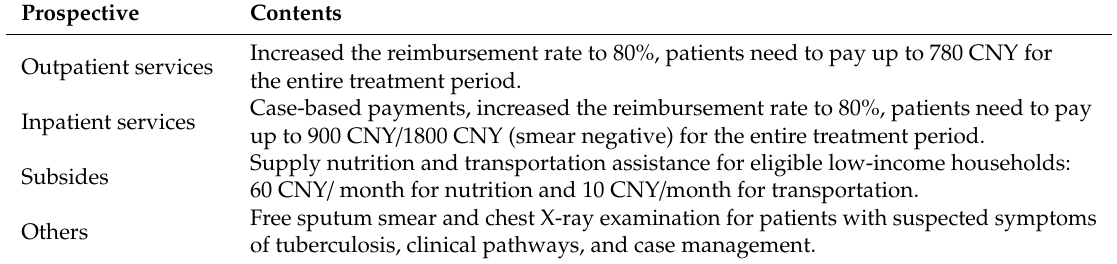
Table A1. Tuberculosis financing and payment model of the China–Gates TB program Phase II.